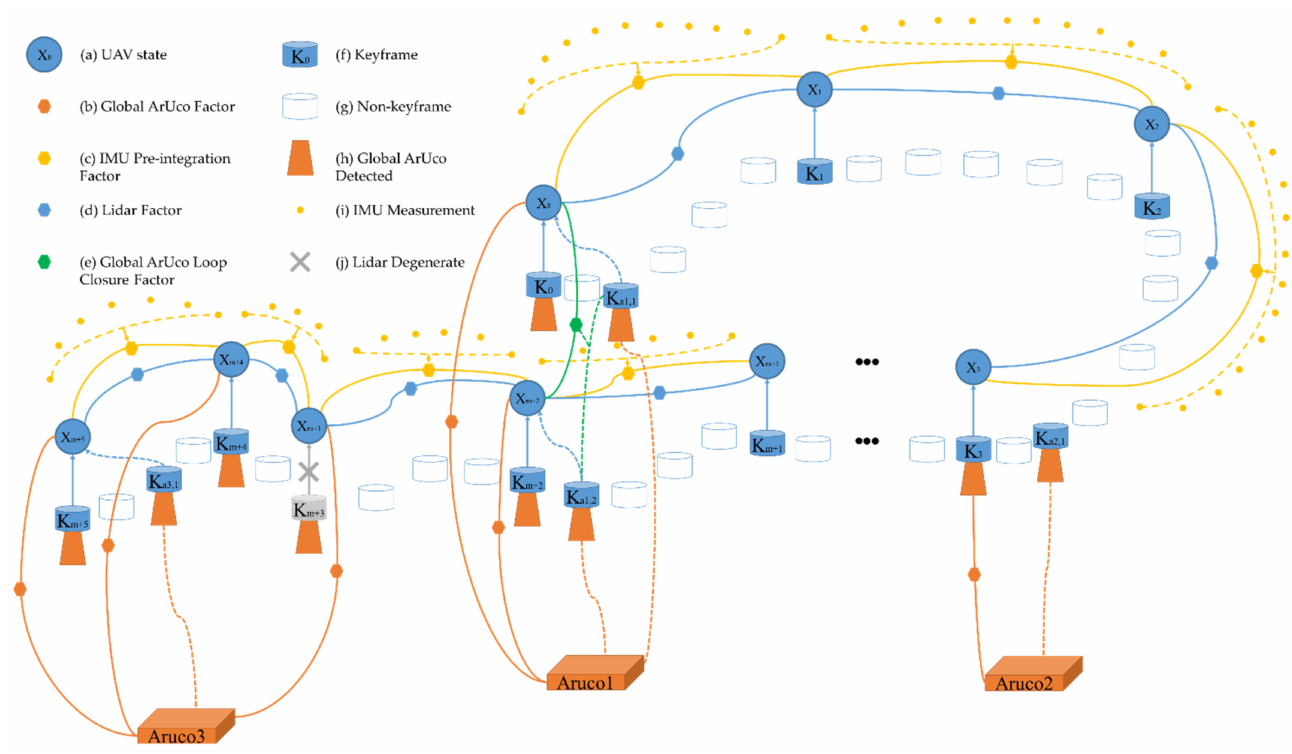
Figure 3. The structure of the factor graph. The system receives input from a camera, an IMU, and a surround Lidar. The factor graph is constructed by four types of factors: (b) global ArUco factor, (c) IMU pre-integration factor, (d) Lidar factor, and (e) global ArUco loop closure factor. The generation of these factors is discussed in the following sections,